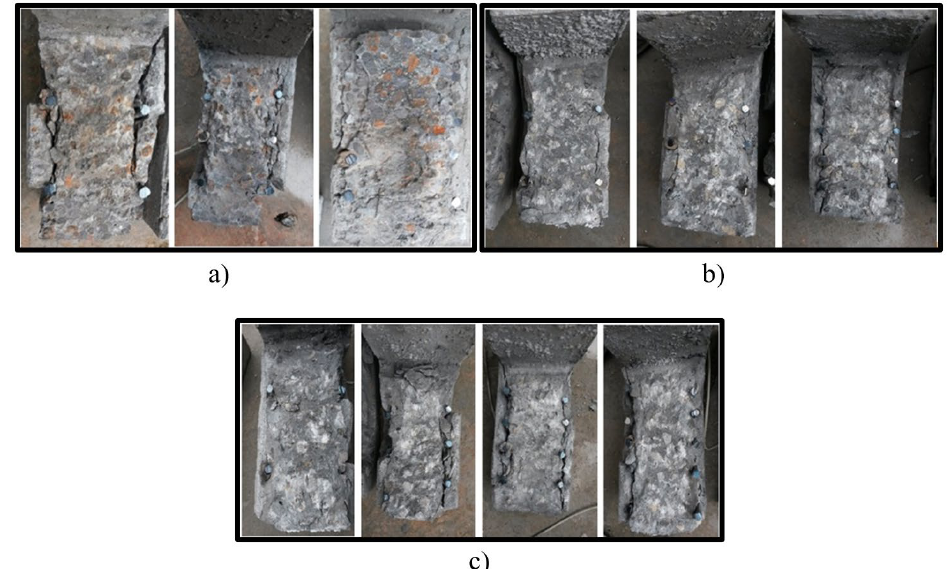
Figure 10. Rupture surfaces: a) sand-lightweight concrete, b) high-strength concrete and c) low-strength concrete.